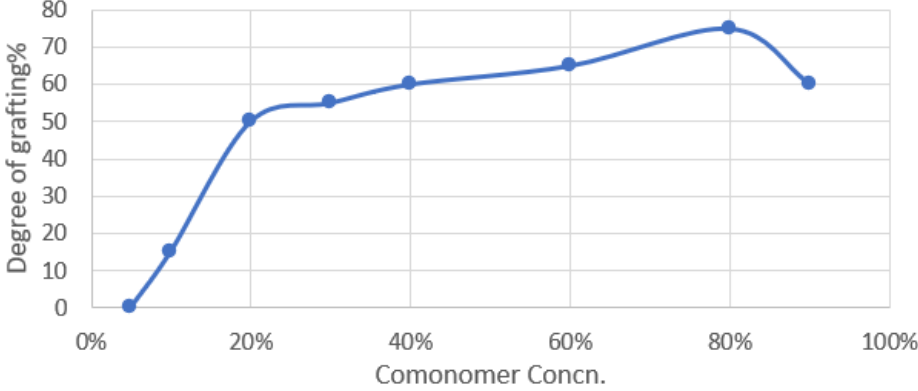
Figure 4. Effect of the comonomer concentration on the degree of grafting on polypropylene at an inhibitor concentration of 2.5 gm FeCl 3 by wt%, at a comonomer composition of 80/20 wt%, and at a solvent concentration of 70% methanol and 30% H 2 O, irradiated at 20 KGy in a nitrogen system.